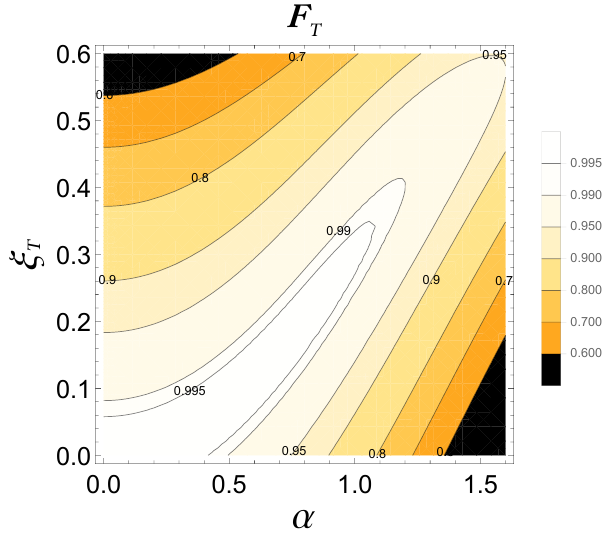
(cid:105) with respect to ξ = T 2 tanh ξ T i α